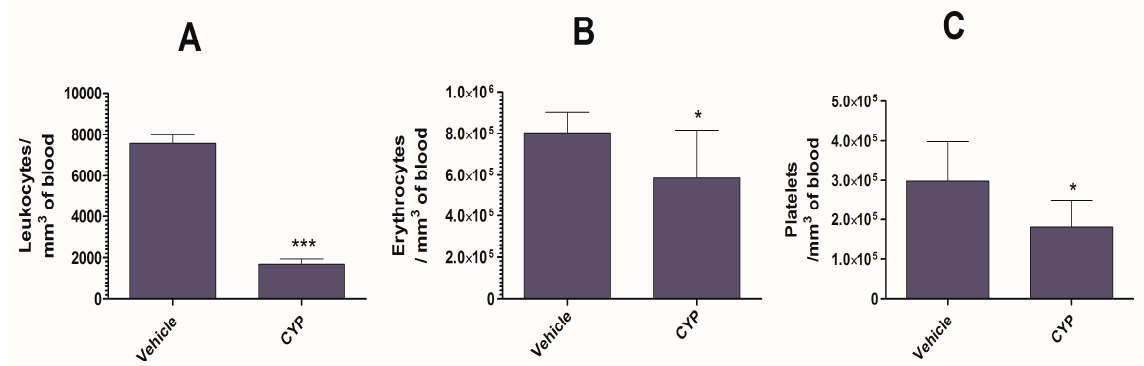
Figure 2. The administration of CYP causes a depletion of ( A ) leukocytes, ( B ) erythrocytes, and ( C ) blood platelets in mice. A p value <0.05 was considered to be significant. * ( p < 0.05), *** ( p < 0.001) Each bar represents the mean ± SD of three different values. The data were analyzed by one-way ANOVA followed by the Turkey